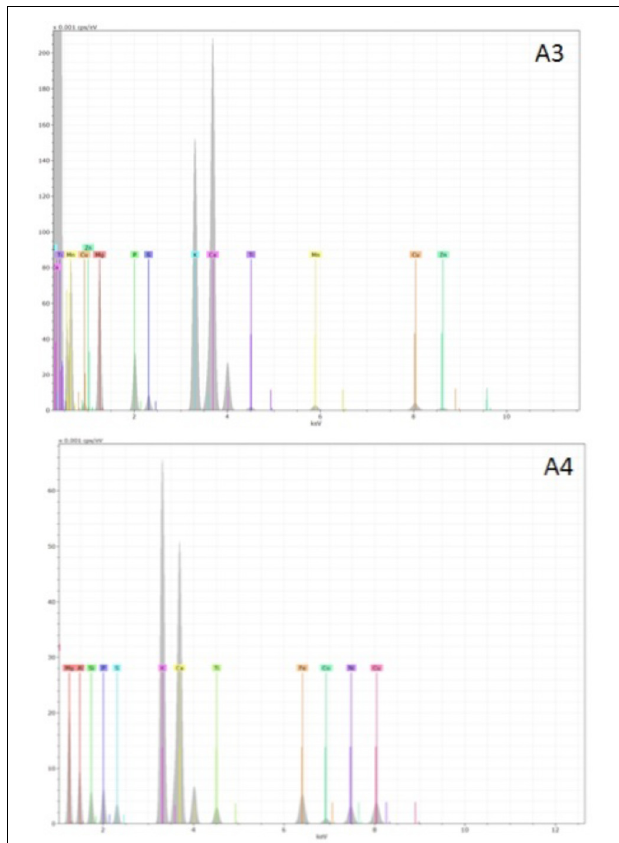
FIGURE 9 | Root growth of Lepidium sativum seedlings germinated for 72 h in the presence of chars from different feedstocks and production processes at increasing concentrations (0.1 to 10 g per plate). Means of 30 seeds are reported with standard errors. Growth in distilled water (control) was 34.29 ± 1.31 cm and is shown as a black bar in all graphs. Asterisks indicate significant differences in the growth of treated samples with respect to control: ∗ p < 0.05; ∗∗∗ p < 0.001. Capital letters indicate significant differences assessed with one-way ANOVA at p < 0.05 between chars tested at the same concentration (in the conditions 0.1, 0.5, and 1 g per plate).